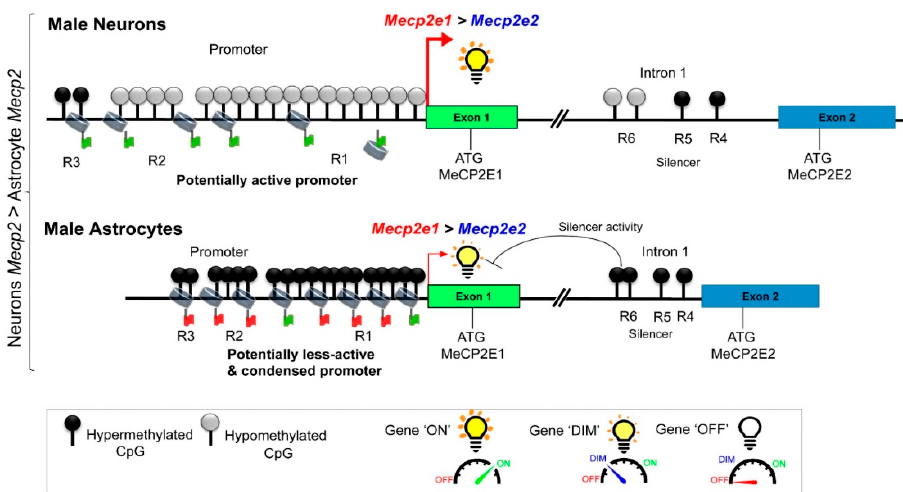
Figure 6. Proposed model for potential control of Mecp2e1 and Mecp2e2 by DNA methylation in male neurons and male astrocytes. Based on the findings of this study, this figure illustrates a summary of the proposed mechanism of Mecp2 regulation by DNA methylation in male neurons and male astrocytes. Higher Mecp2 expression levels in male neurons compared to male astrocytes could be in part driven by lower DNA methylation. It is possible that a lower DNA methylation at the Mecp2 promoter in male neurons may induce an “active chromatin conformation”, allowing higher transcription. In contrast, higher DNA methylation at the Mecp2 promoter in male astrocytes may cause a “less active and more condensed chromatin conformation”, leading to lower Mecp2 level. We propose that DNA methylation may act as a switch for fine-tuning of the Mecp2 gene expression from “ON” (active promoter) to “DIM” (less active promoter) to “OFF” (repressed promoter).